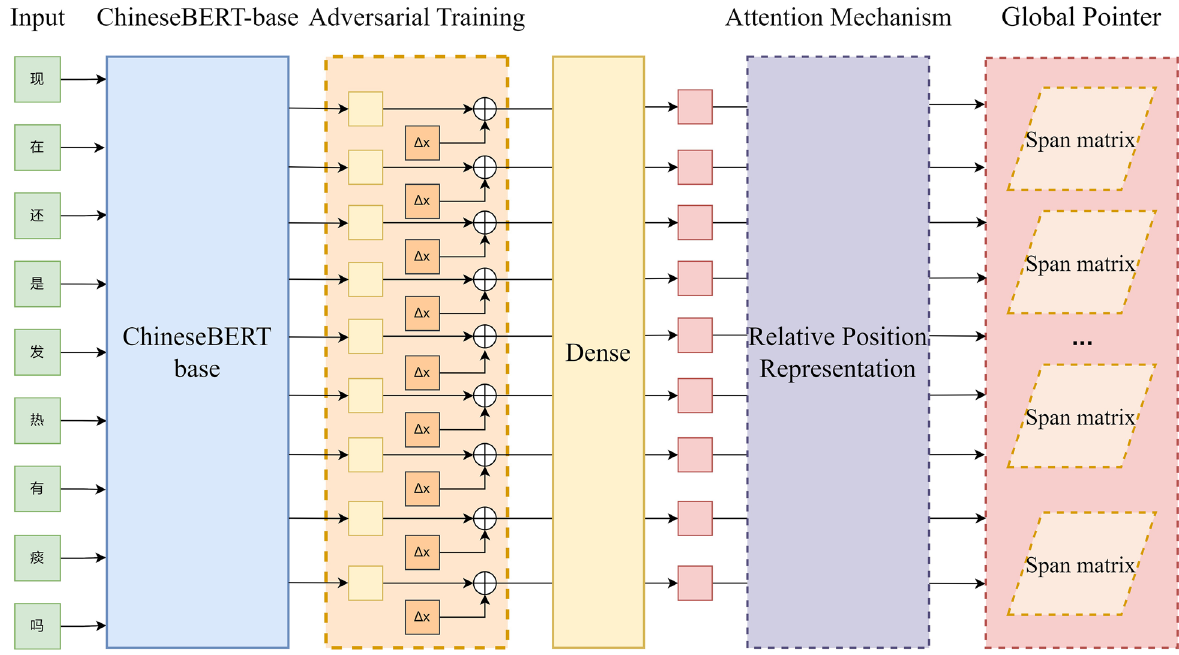
Figure 1. The Architecture of AT-CBGP: The AT-CBGP is a Bert-based model. The output of the model is the NER results in span matrix form for given input